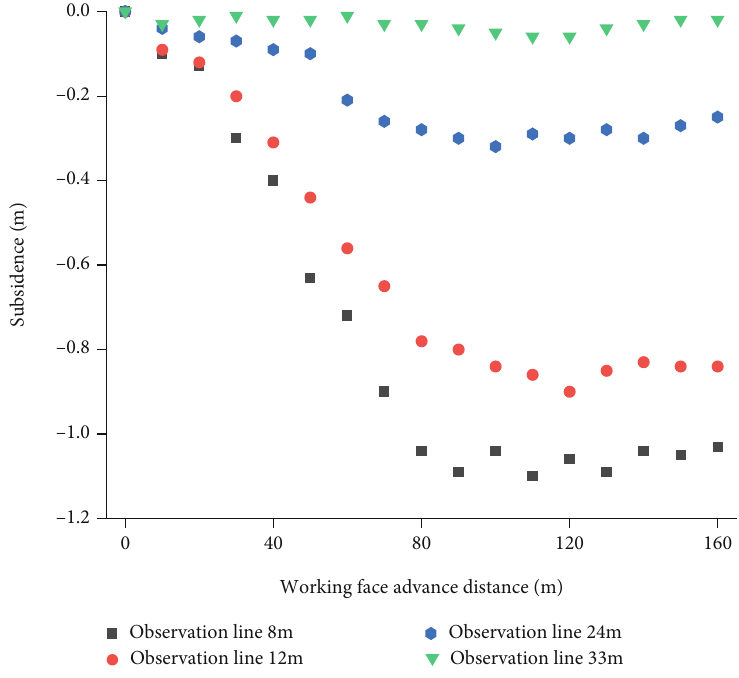
Figure 7: Variation curve of sinking volume of each measurement